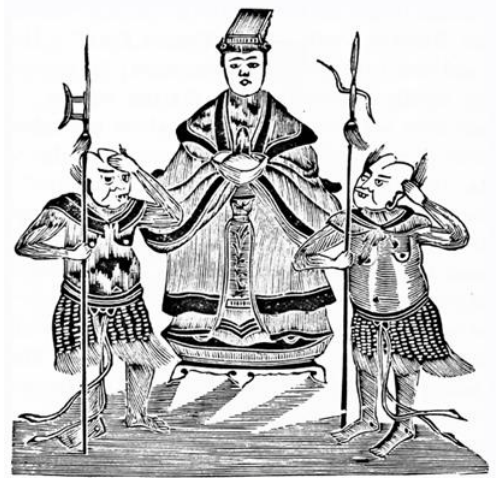
Figure 7. Printmaking Mazu. Source: The Dragon, Image, and Demon, 1886, p. 388.